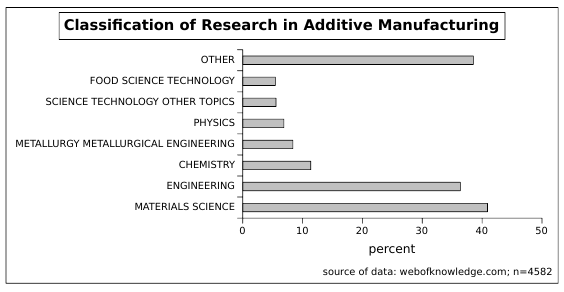
Figure 3. Classification of articles for Additive Manufacturing; source of data: